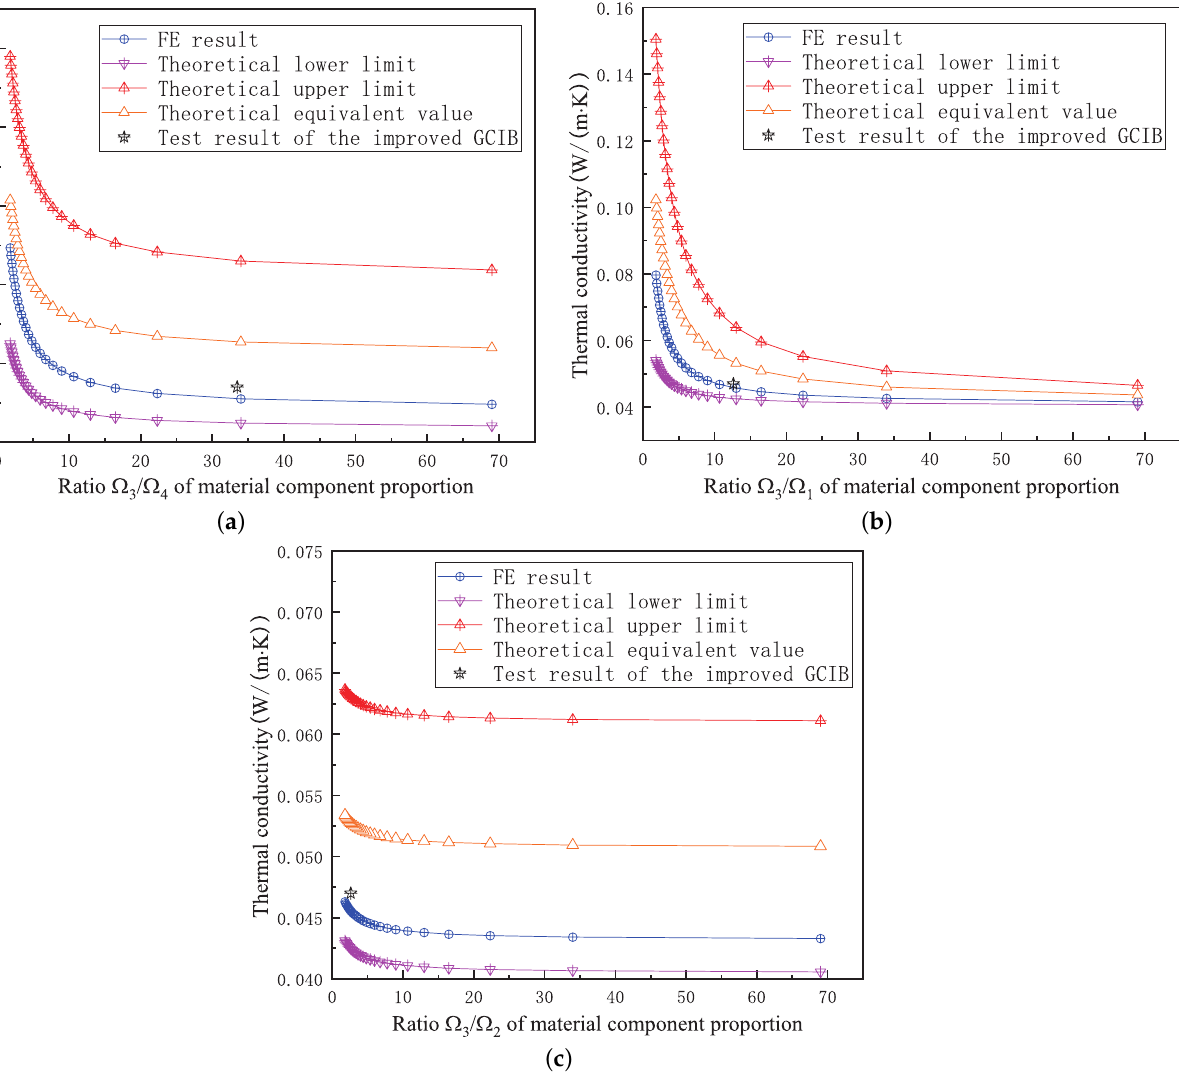
Figure 15. Influence curve of thermal conductivity under component material proportion ratio Φ : ( a ) Φ = Ω 3 / Ω 4 ; ( b ) Φ = Ω 3 / Ω 1 ; ( c ) Φ = Ω 3 / Ω 2